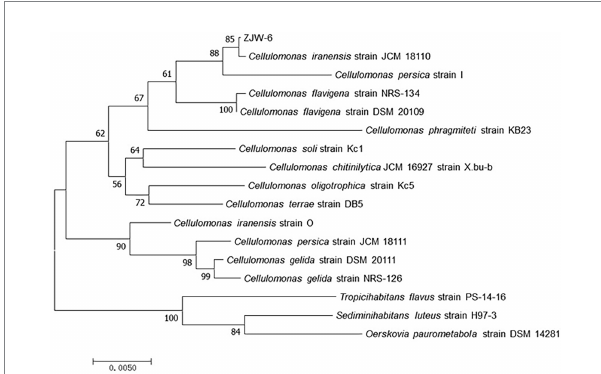
FIGURE 4 Neighborhood-joining tree based on 16S rRNA-encoding gene sequences of strain ZJW-6 and those species of Cellulomonas genus in NCBI database. The 16S rRNA-encoding gene sequences of Tropicihabitans flavus , Sediminihabitans luteus and Oerskovia paurometabola were used as outgroups. Only bootstrap values above 50% (percentages of 1,000 replications) are indicated. The numbers at nodes are bootstrap values from 1,000 replicates of the consensus tree. The scale bar represents 0.5% nucleotide sequence divergence. The GenBank accession numbers for the sequences used to generate the phylogenetic tree are as follows: Cellulomonas iranensis strain JCM 18110, NR 114319.1; Cellulomonas persica strain I, NR 024913.1; Cellulomonas flavigena strain NRS-134, NR 037027.1; Cellulomonas flavigena strain DSM 20109, NR 074490.1;